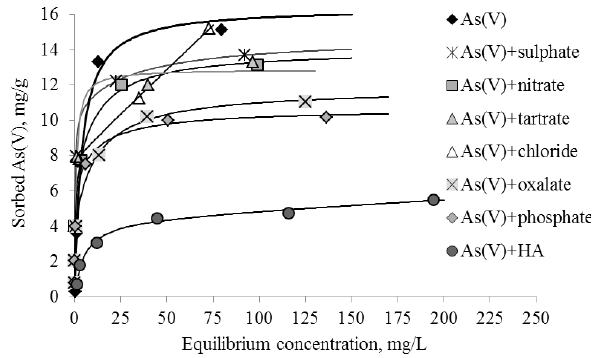
Figure 7: Influence of competing substances on sorption of As(V). Sorbent – Fe-modified peat (from the Gagu Bog), concentration of competing ions – 25 mg L -1 , C – 12.5 mg L -1 , sorption time 24 h at HA room